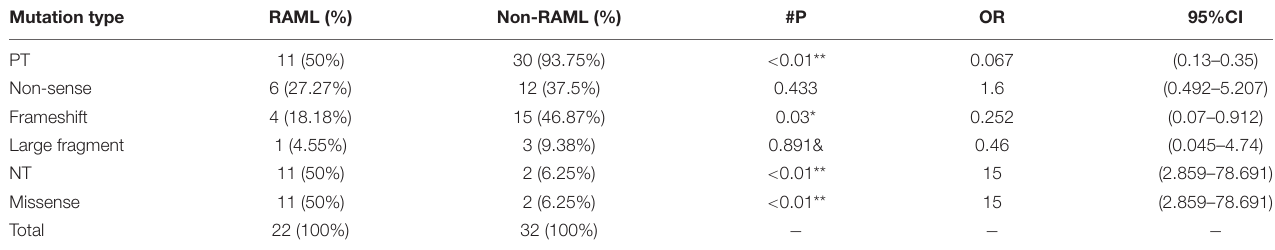
TABLE 1 | Relationship between different types of TSC1 gene mutation and